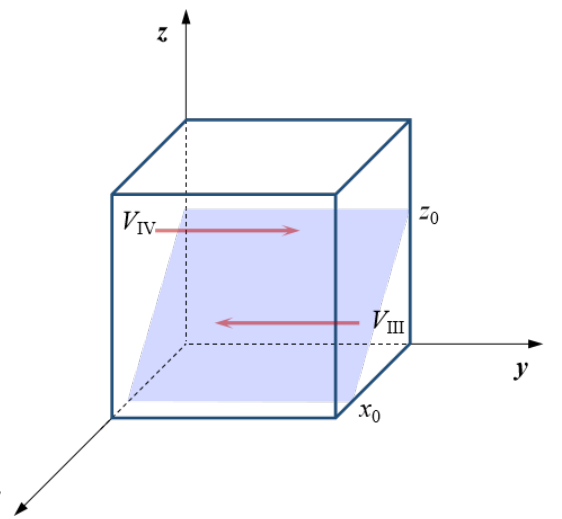
Figure 3. Evolutionary phase diagram of the neighboring government ’s strategy.